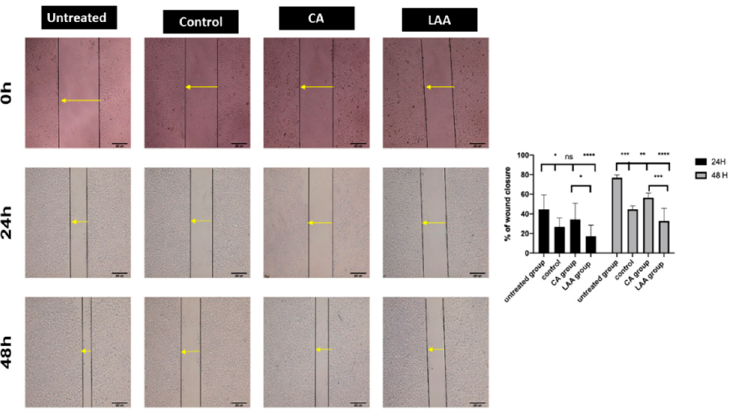
Figure 4. Migration assay at 0, 24 and 48 h. Statistical analysis for the % of wound closure of different groups at 24 and 48 h. * Significance at p < 0.05, ** significance at p < 0.001, *** significance at p = 0.0001, **** significance at p < 0.0001.